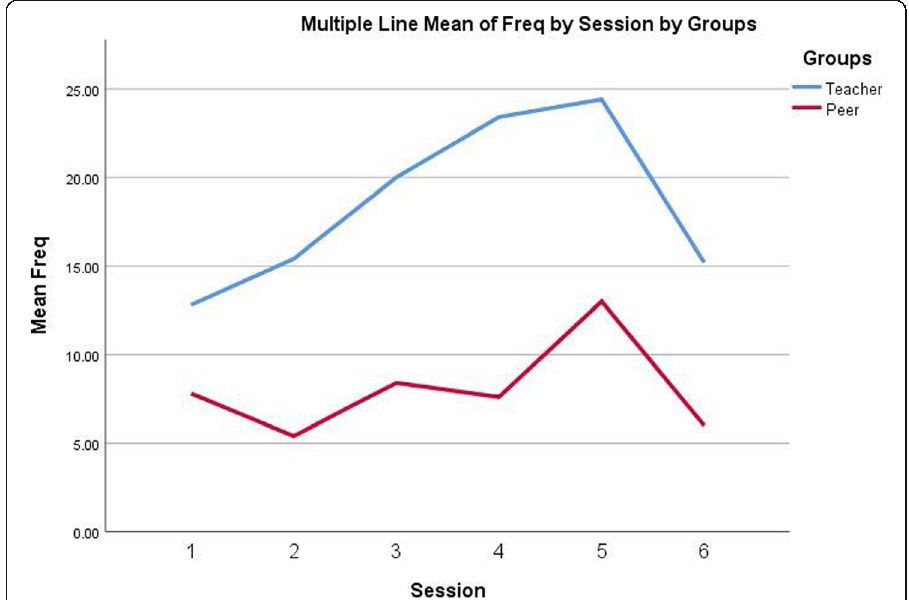
Fig. 2 Magnitude of TA and PA on descriptive